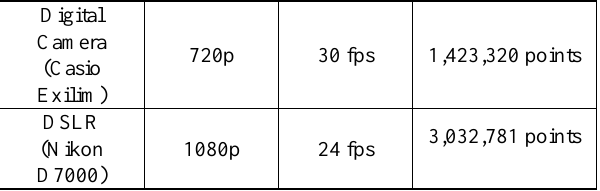
Table 6. Total number of point clouds